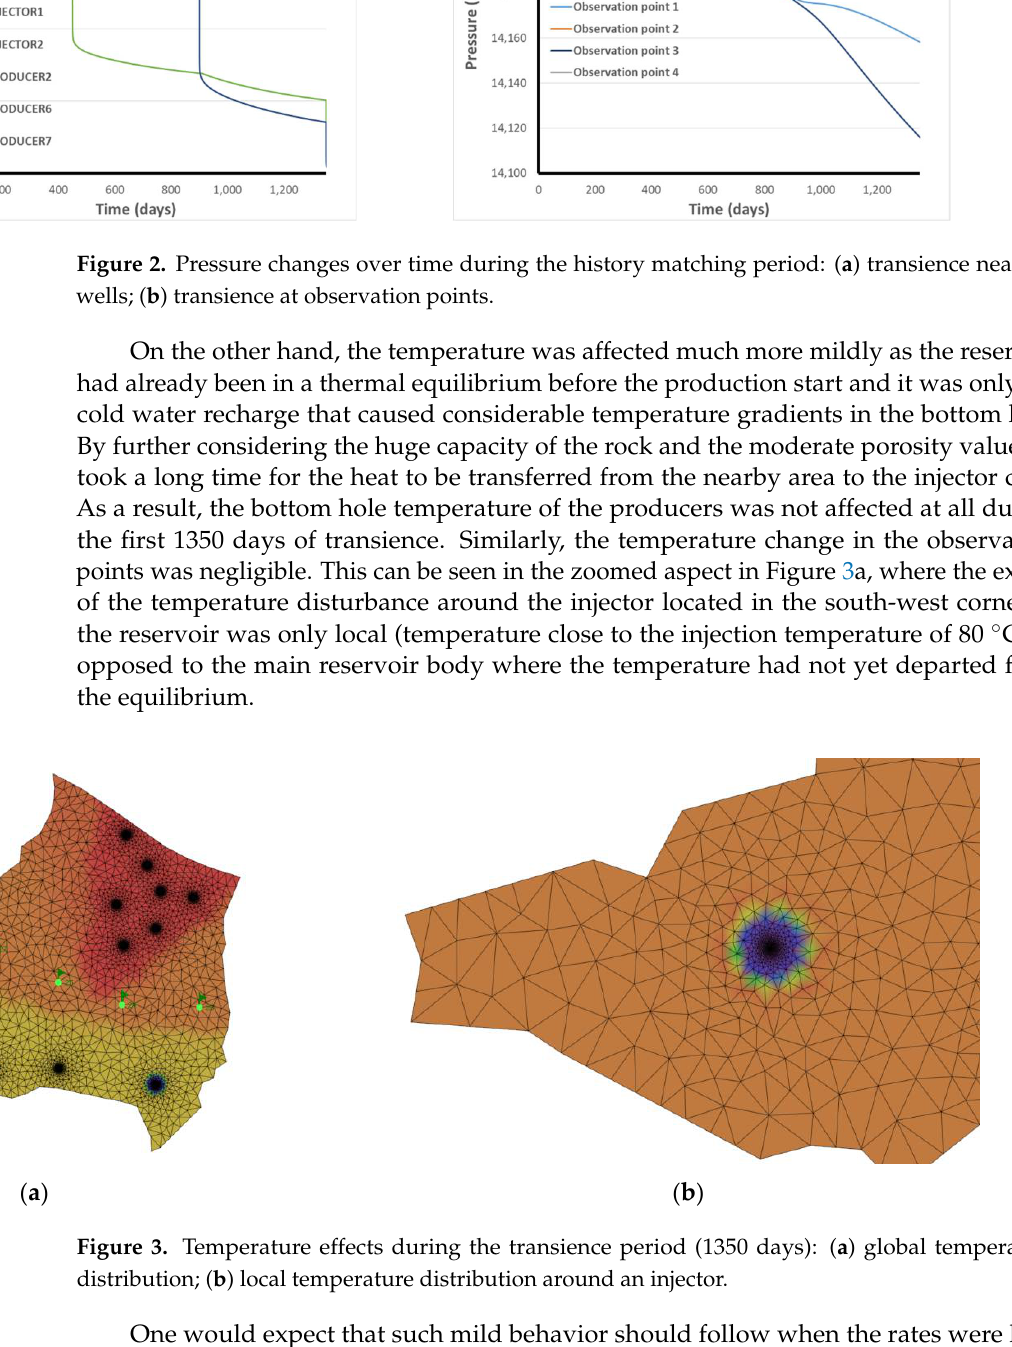
Figure 2. Pressure changes over time during the history matching period: ( a ) transience near the wells; ( b ) transience at observation points.